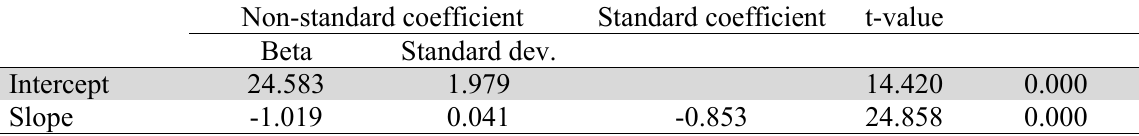
Non-standard coefficient Standard